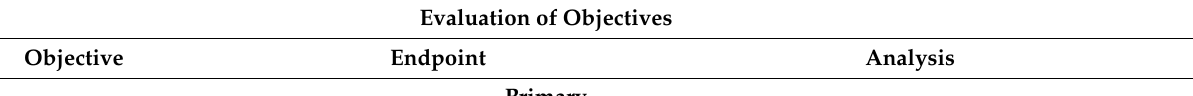
Table 1. Objectives and outcome